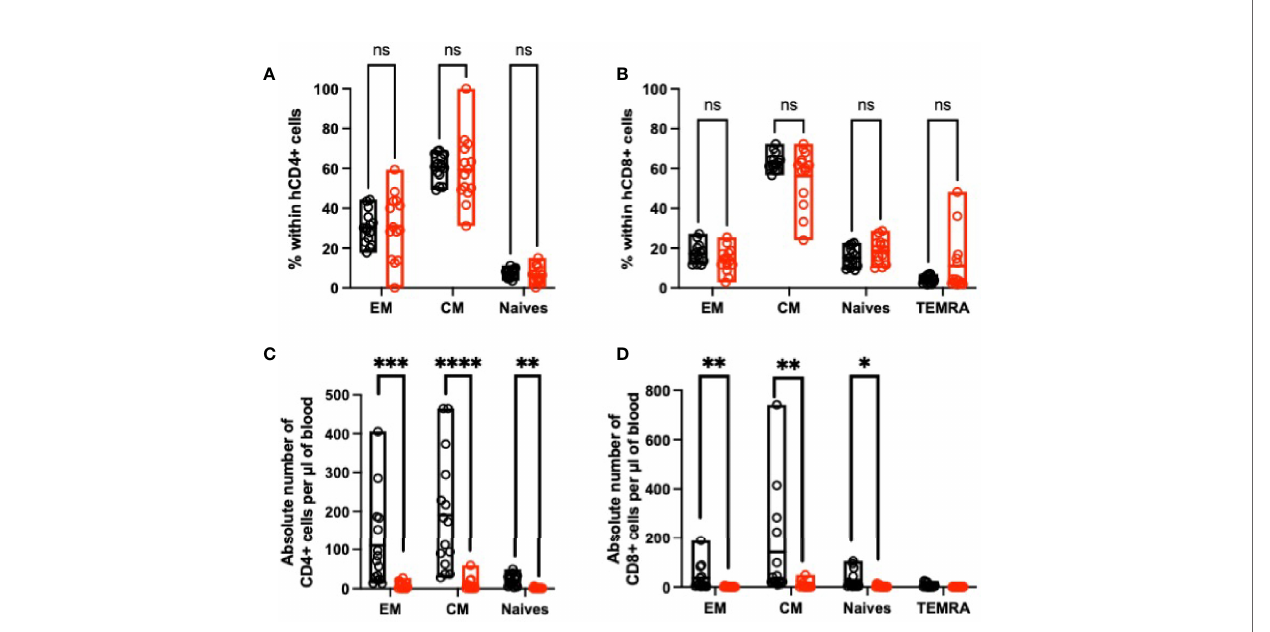
FIGURE 7 | Inhibition of SIRP a - g /CD47 interactions alters blood memory cells in humanized mice. At Day 14, blood cells were analyzed by FACS. (A) Percentage of human CD4 and (B) CD8 subpopulations are presented based on FACS analysis with the following patterns CD45RA − CD27 − effector memory cells (EM), CD45RA − CD27 + central memory cells (CM), CD45RA + CD27 + -naïve cells, and CD4 − CD45RA + CD27 − for TEMRA CD8 cells. (C) Absolute number of each subpopulation of CD4 + and (D) CD8 + T cells are presented. n = 3 experiments with PBMC from three different HV. Data were analyzed with a one-way ANOVA test followed by Kruskal-Wallis. * p ≤ 0.05; ** p ≤ 0.01; *** p ≤ 0.001; **** p ≤ 0.0001; ns, not signi fi